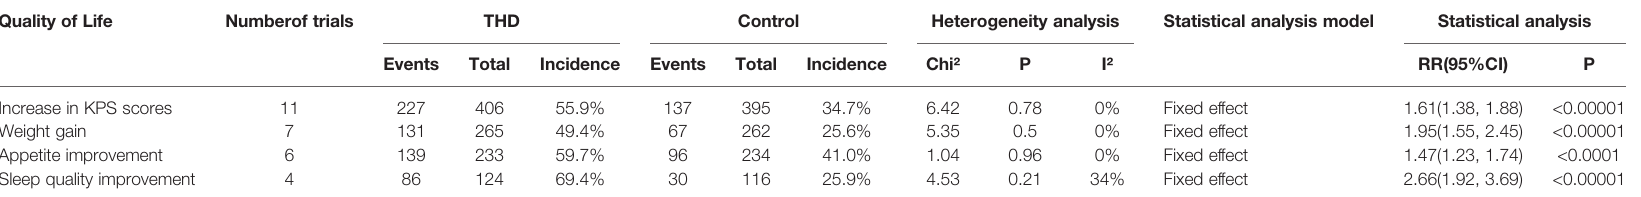
TABLE 3 | Meta-analysis on